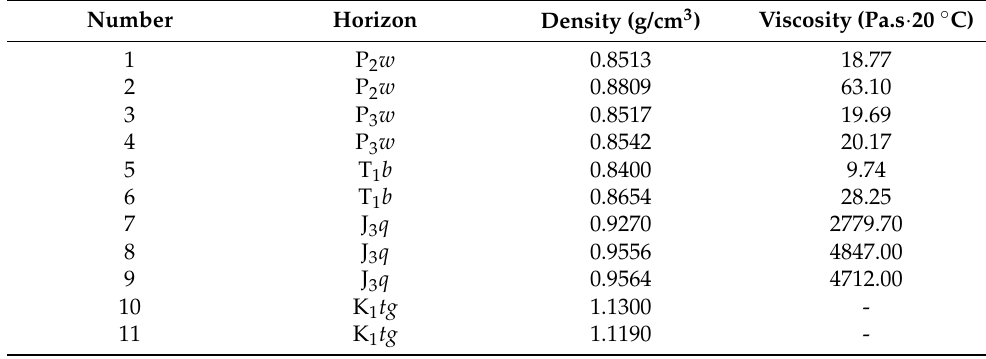
Table 2. Density and viscosity data of crude oil samples in Wuerhe